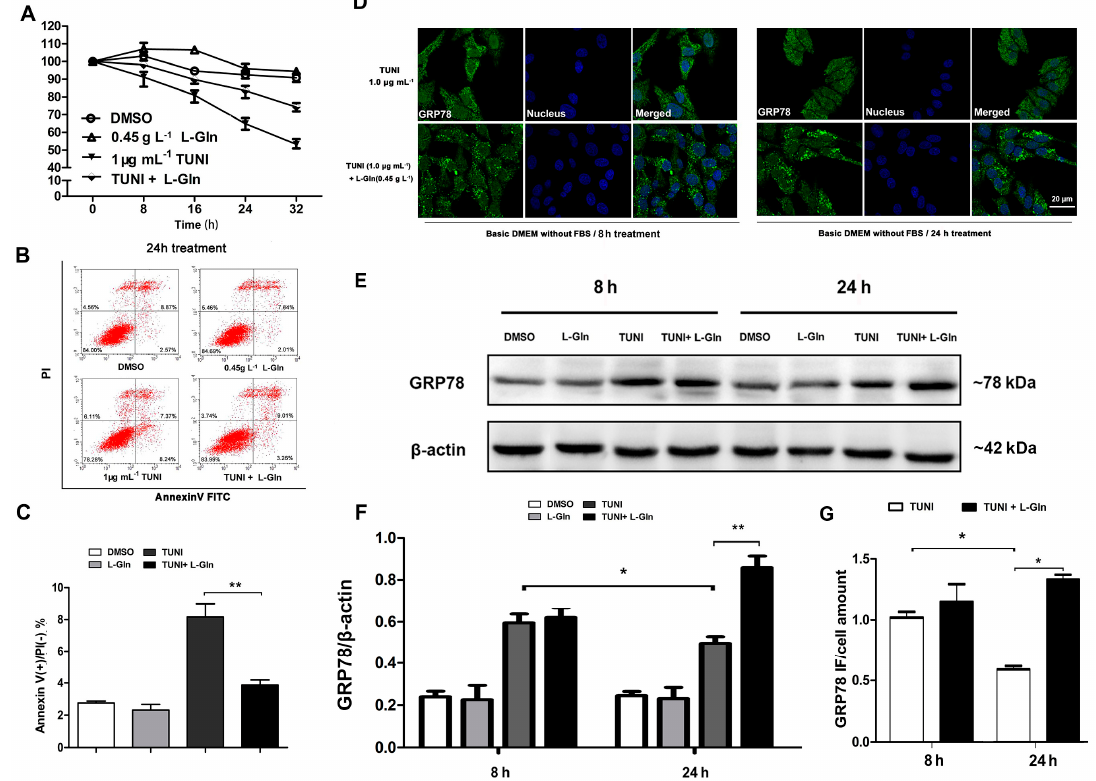
Figure 3. L -glutamine protects cell from TUNI-induced apoptosis. In basic DMEM, cells were treated with DMSO, 0.45 g L − 1 L -glutamine and 1.0 µ g mL − 1 TUNI or a combination of L -glutamine and TUNI for 0 to 32 h. ( A ) Relative cell viability was measured using CCK-8; ( B ) PI/Annexin V-FITC staining and cell fluorescent screening were performed by flow cytometry; ( C ) Statistical results of Annexin V(+)/PI( − ) staining; ( D ) GRP78 and nucleuses of cells in 8 and 24 h treatments were fluorescence labelled with Alexa Fluor 488 and DAPI, and excitation fluorescence was captured by laser scanning confocal microscopy; ( E ) Western blot analysis of GRP78 protein after ERS induction for 8 or 24 h; one representative protein band from the three independent experiments is shown; ( F ) Relative abundance of GRP78; ( G ) Relative fluorescence intensity of GRP78. Data given as means ± SDs for the three independent experiments (* means under T test, p < 0.05, ** means under T test, p < 0.01).